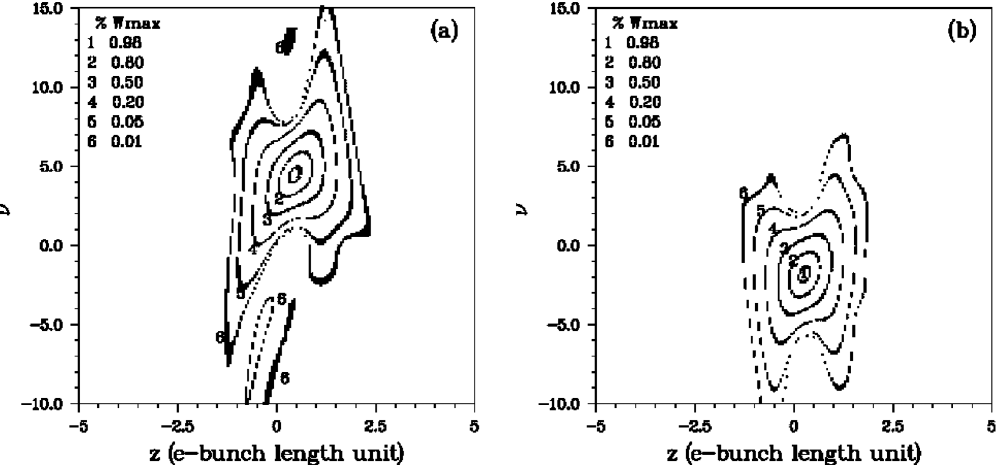
¼ (cid:1) 4 , : (a) (cid:7) c c ¼ (cid:8) ¼ z